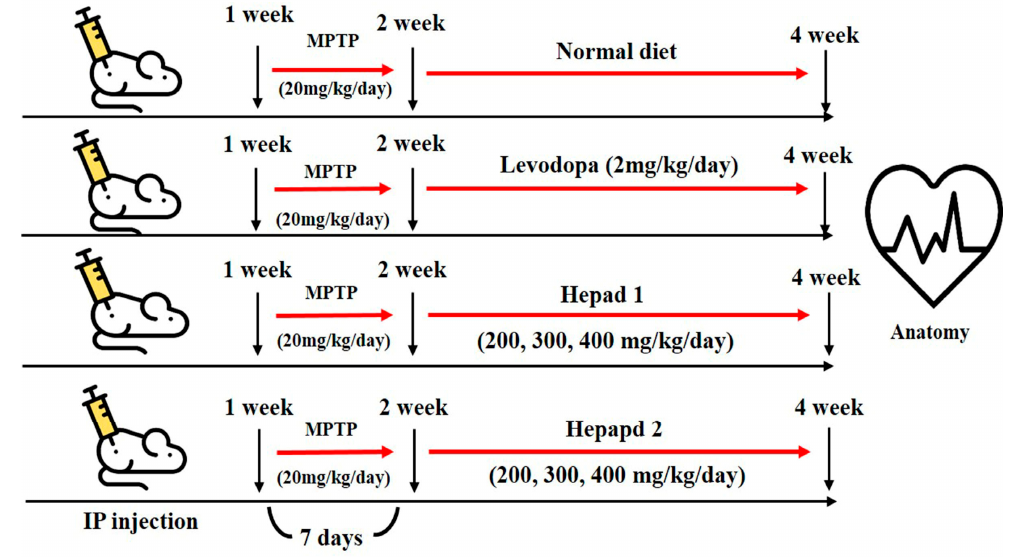
Figure 7. Flowchart depicting the timeline of the experimental procedures.